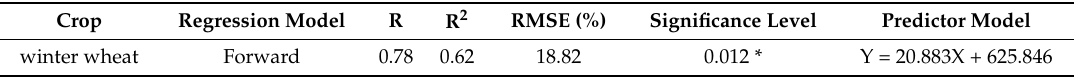
Table 9. Regression and correlation results of the yield and precipitation data.